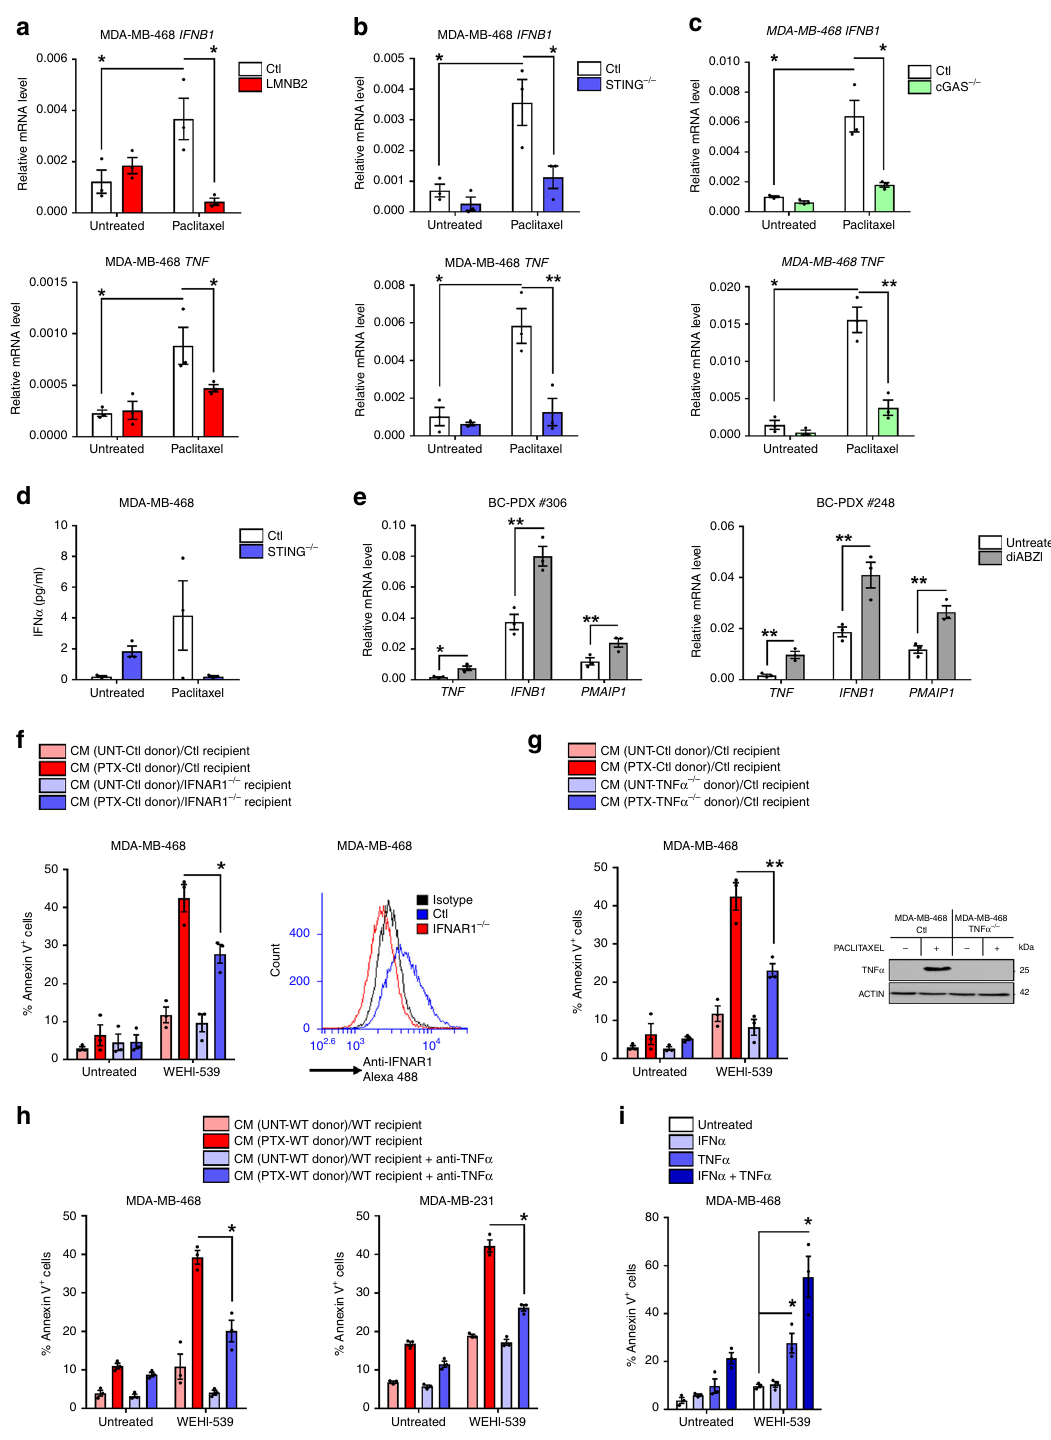
Fig. 4 STING-dependent induction of TNF α and type I IFN triggers a proapoptotic secretome. a – c IFNB1 and TNF qPCR analysis in LMNB2 overexpressing ( a ), STING − / − ( b ) or cGAS − / − ( c ) and control MDA-MB-468 cells after 24 h paclitaxel treatment. d IFN α production before and after paclitaxel treatment in control or STING − / − MDA-MB-468 cells. e TNF, IFNB1 and PMAIP1 qPCR analysis in BC-PDX #306 and BC-PDX #248 after a 48 h- treatment by the STING agonist diABZI. f 24 h-paclitaxel-treated or not (donor) cells were washed out to produce 48 h-conditioned media (CM) that were applied to untreated (recipient) IFNAR1 − / − cancer cells for 48 h in presence or not of the BH3 mimetic WEHI-539. Apoptotic index in recipient breast cancer cells was assessed using Annexin-V staining. IFNAR1 expression was detected by cytometry after immunostaining (right panel). g Same experiment as ( f ) using control or TNF α − / − MDA-MB-468 donor cells and TNF α expression was detected by immunoblot analysis in monensin-treated cells for 72 h after 24 h paclitaxel treatment or not (right panel). h Same experiment as ( f ) using TNF α blocking antibody preincubated in CM before addition to MDA- MB-468 (left) or MDA-MB-231 (right) recipient cells. i Apoptotic effect of recombinant IFN α and/or TNF α on MDA-MB-468 cells treated or not with WEHI-539 during 48 h. Data were collected from at least n = 3 independent experiments. Error bars indicate mean + / − SEM; Two-sided paired t -test. The symbols correspond to a p -value inferior to *0.05 and